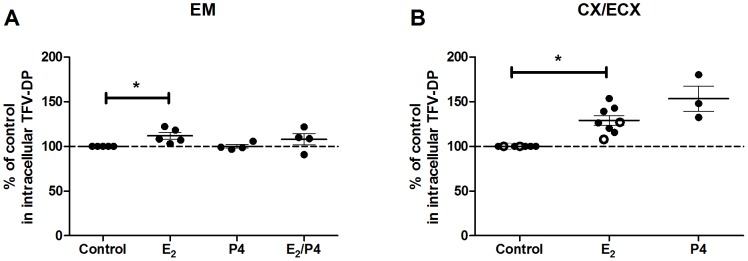
Effect of estradiol and/or progesterone on TFV-DP levels in epithelial cells from endometrium, endocervix and ectocervix.TFV-DP levels were measured by LC-MS/MS in polarized cultures of FRT epithelial cells treated with TFV (1 mg/ml) and estradiol (5×10−8 M), progesterone (1×10−7 M), either alone or the combination for 24 hr. Data were normalized to % of control values from (A) EM epithelial cells (n = 4–5) and (B) CX/ECX epithelial cells (n = 3–8). Dashed line indicates an assigned value of 100. Each circle represents a different patient. Dark circles indicate (A) EM epithelial cells and (B) CX epithelial cells. Open circles indicate ECX epithelial cells. The mean and SEM are shown. *, p<0.05.